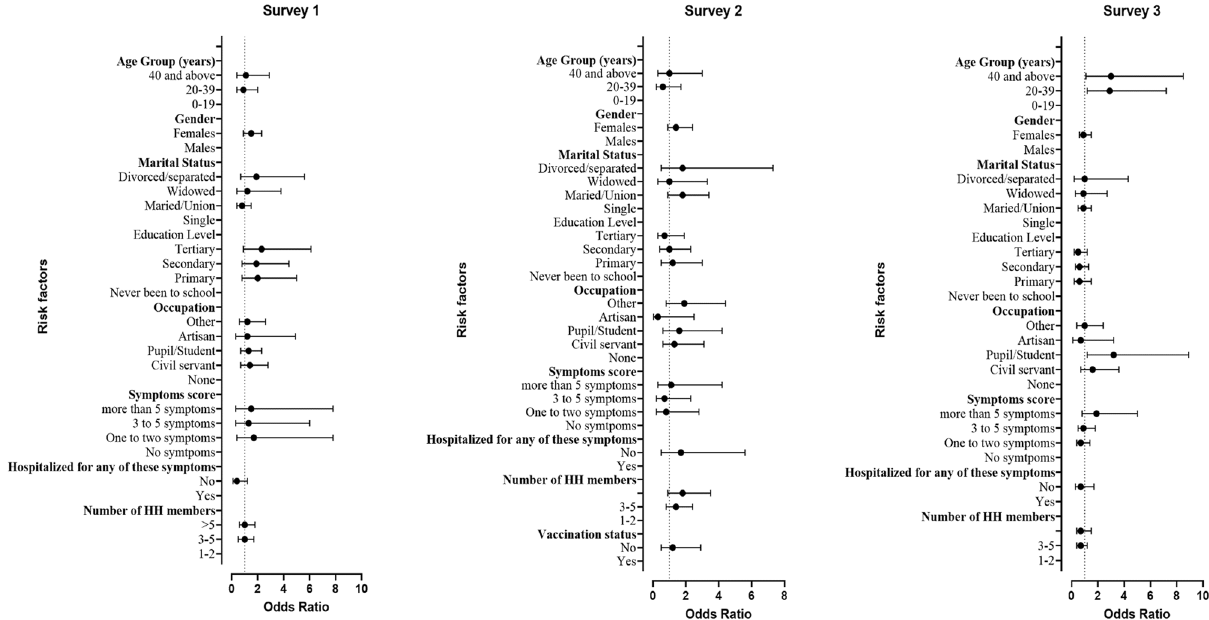
Figure 4. Forest plot of odds ratios of risk factors associated with Sars-Cov-2 seroprevalence in 3 consecutive surveys. Dots represents odds ratio and the bar is the confidence